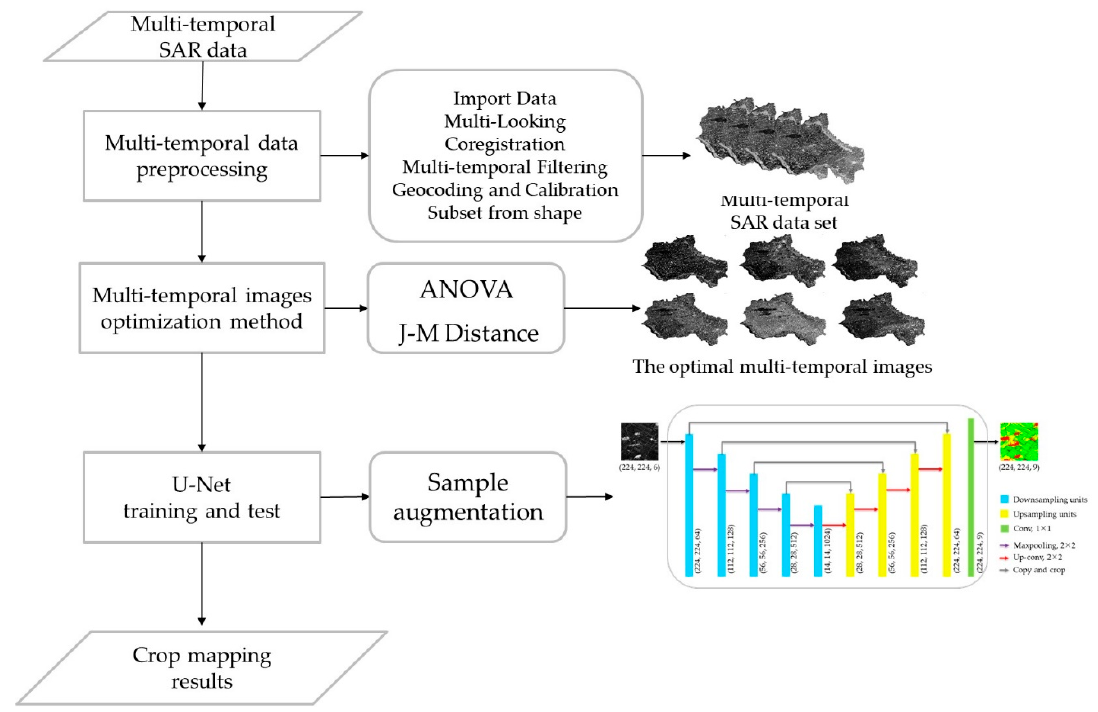
Figure 1. Flow chart of Multi-temporal SAR data crop mapping method.